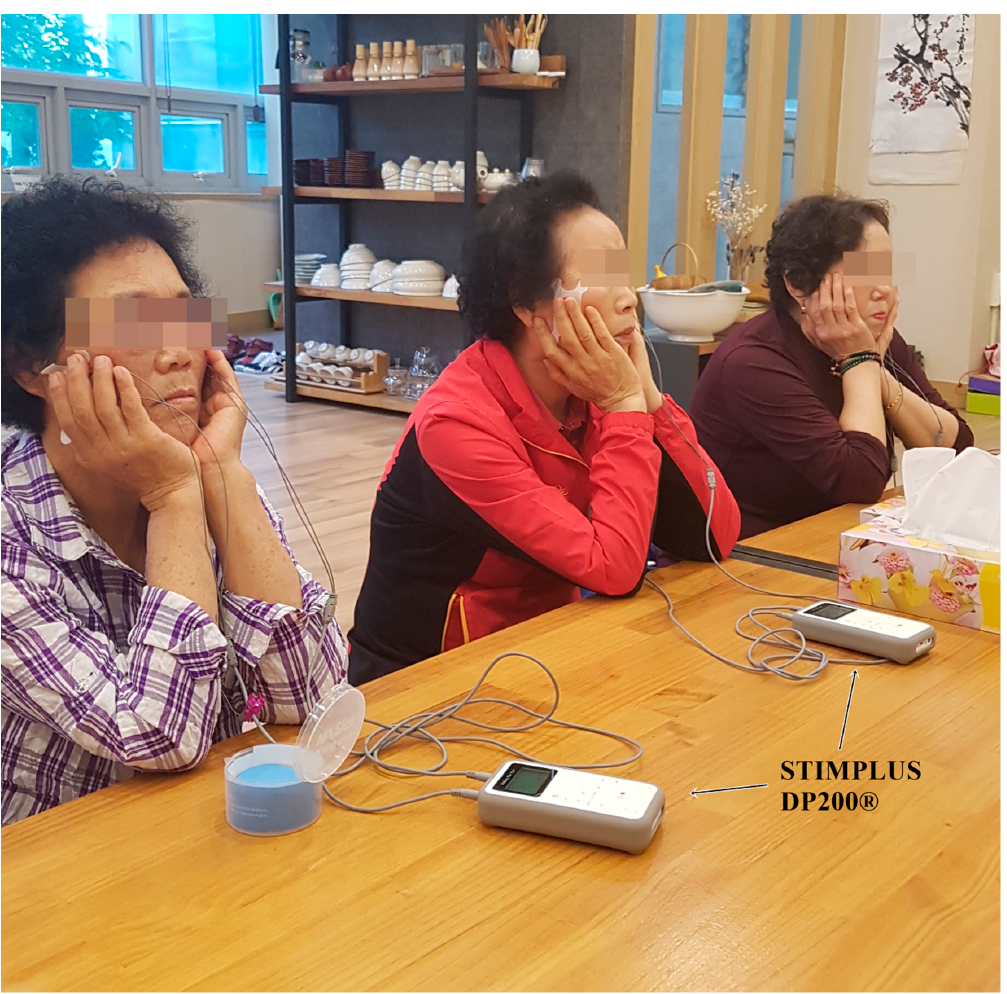
Figure 2. Neuromuscular electrical stimulation applied to both masseter muscles. Int. J. Environ. Res. Public Health 2020 , 17 , x